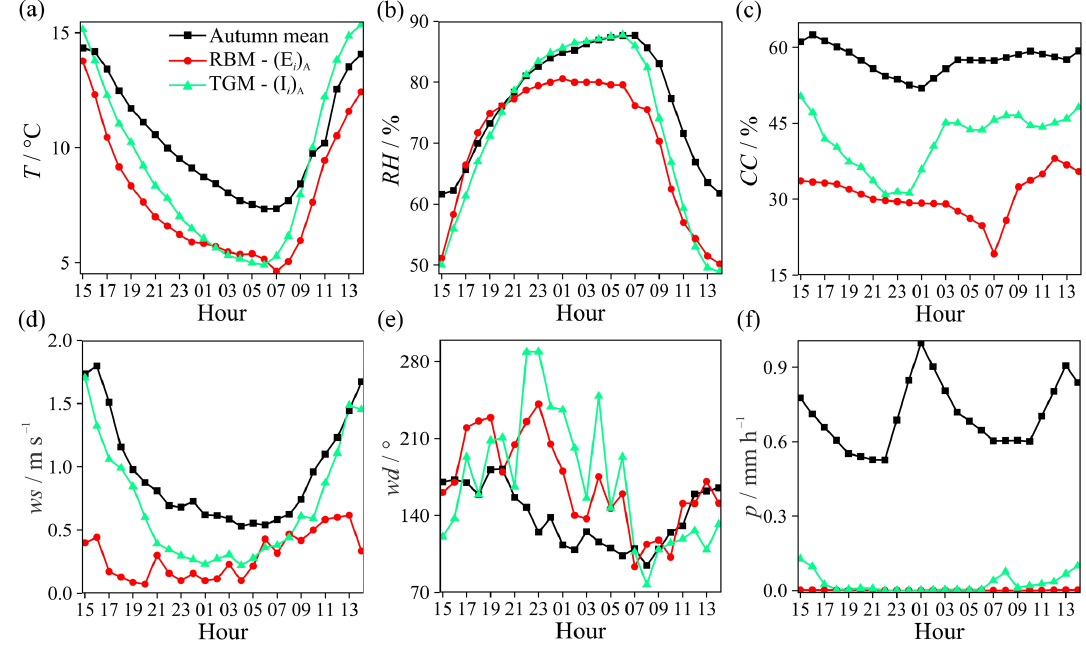
Figure 13. Diurnal composites, based on hourly means, of (a) air temperature, (b) relative humidity, (c) cloud cover, (d) wind speed, (e) wind direction, and (f) precipitation, for autumn mean, and persistent temperature inversion events detected in autumn by the RBM and TGM.